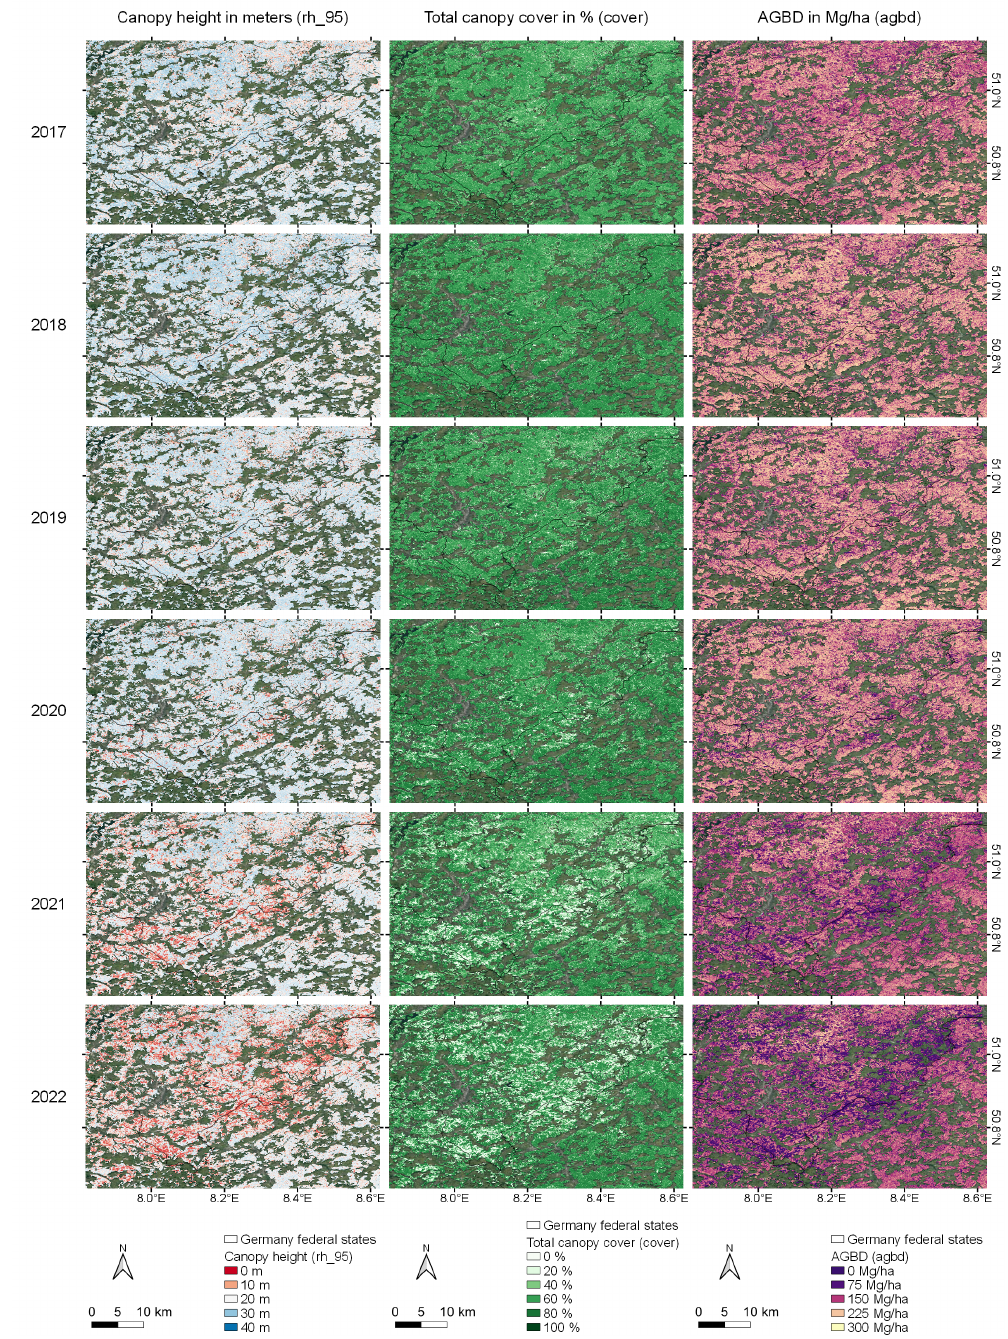
Figure 11. Forest structure change in the Siegen-Wittgenstein region (2017 to 2022). Major changes are taking place in 2021 and 2022 as the result of large-scale salvage logging in coniferous